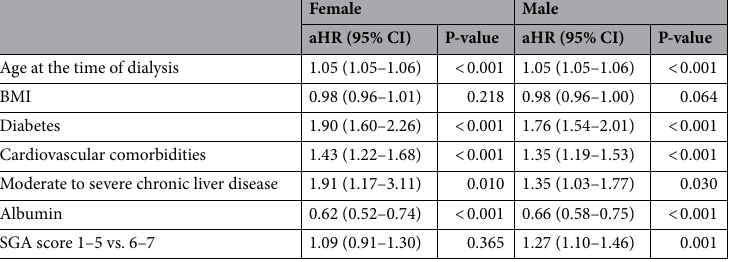
Table 5. Factors associated with all-cause mortality according to sex in the multivariable regression analysis. BMI body mass index, CI confidence interval, aHR adjusted hazard ratio, SGA subjective global assessment. Models were adjusted for age at the time of dialysis, BMI, diabetes, cardiovascular comorbidities, chronic lung disease, moderate to severe chronic liver disease, malignancy, albumin, hemoglobin, calcium, phosphorus, SGA scores, and dialysis vintage.